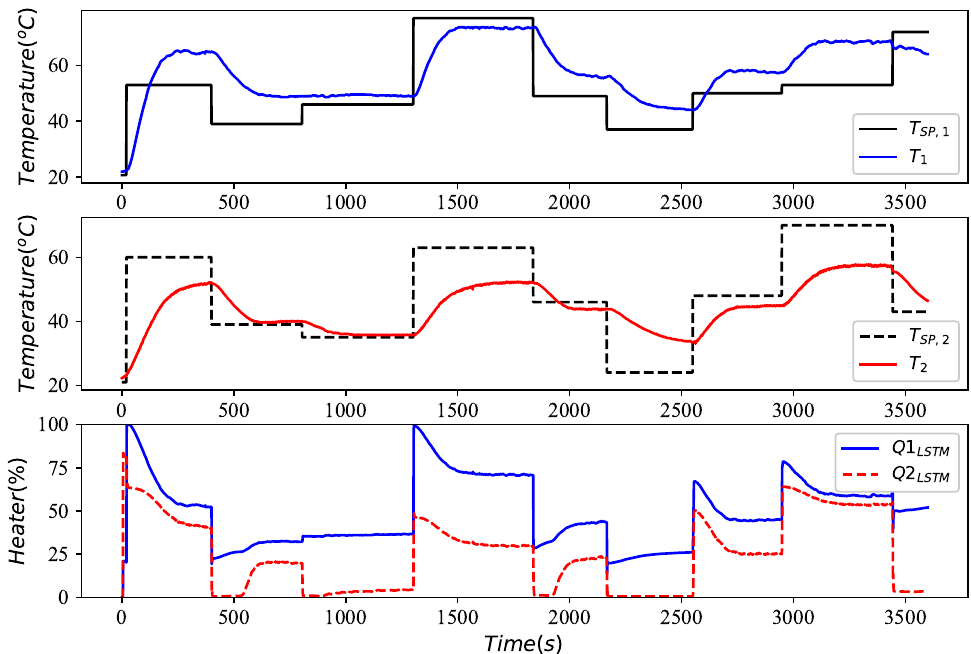
Figure 7. Scenario 2. Temperature and heater output of an approximate MPC control deployed online to a small-scale temperature control (target system). The approximate MPC control is trained using only source